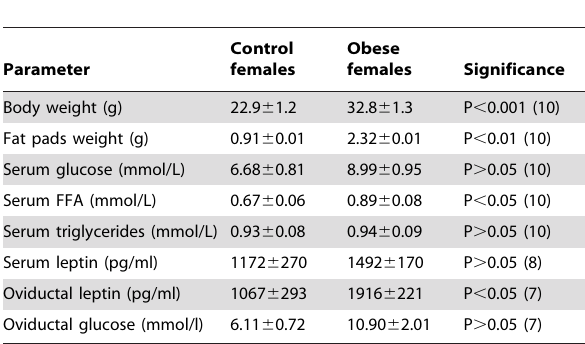
Table 1. Maternal weights and metabolic parameters.